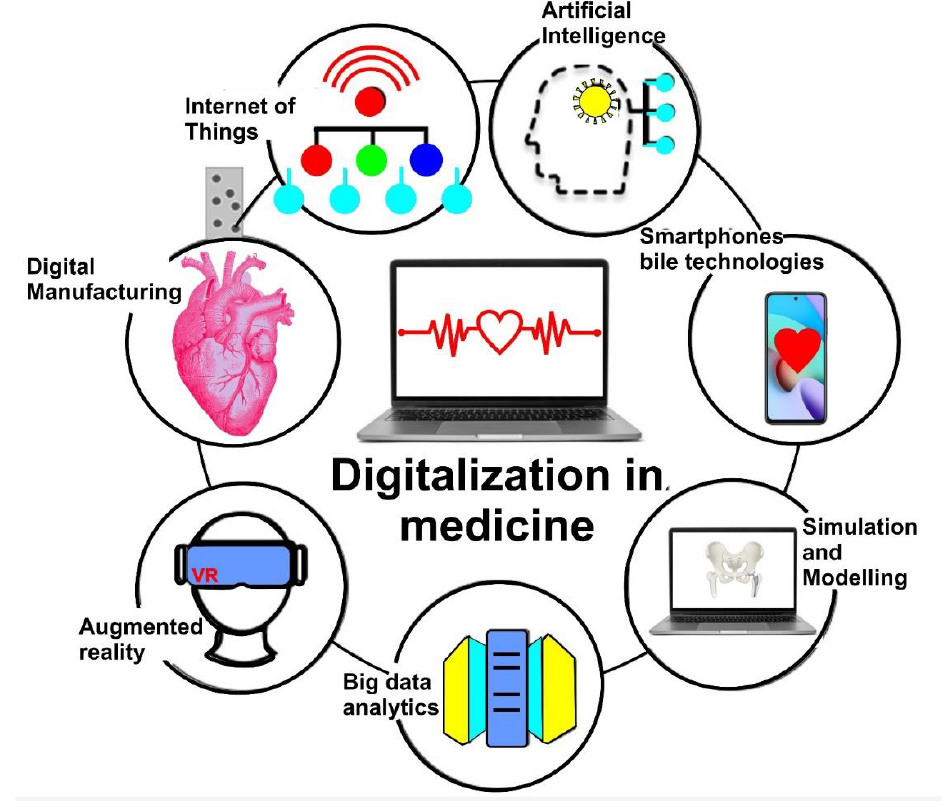
Figure 4. Digitalisation in medicine — main technologies.